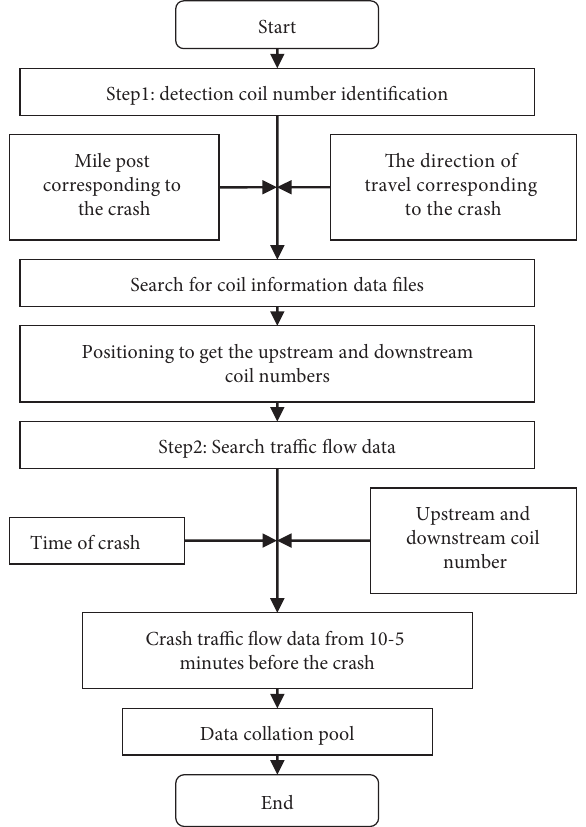
Figure 2: Matching fowchart of the crash data and trafc fow